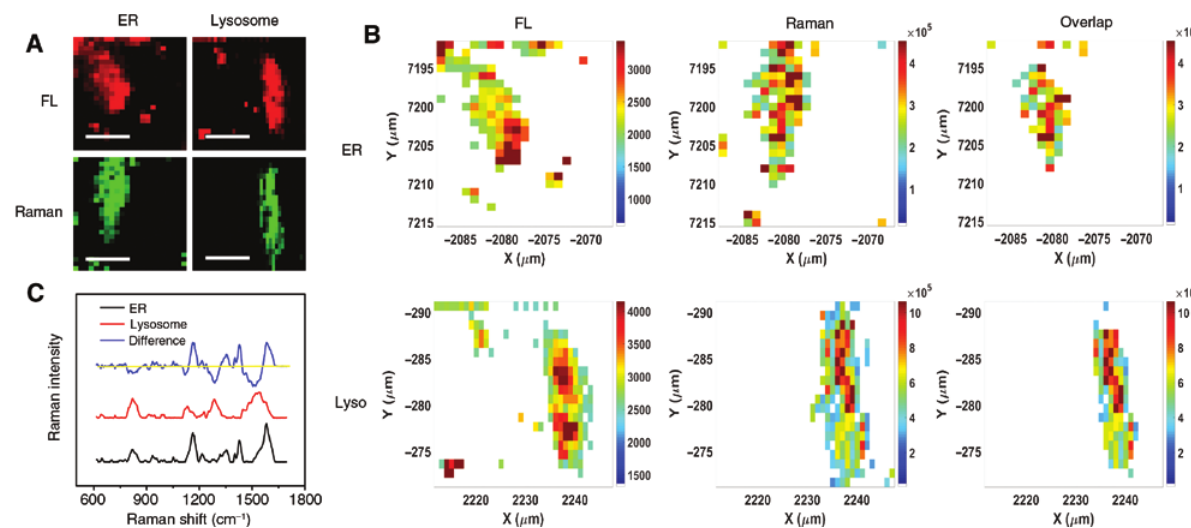
Figure 6: (A) SERS-fluorescence dual-mode imaging analysis of the subcellular localization of BP-Au NSs. Scale bar: 20 μ m. (B) Overlap analysis of the FL and SERS images. (C) SERS spectra extracted from the ER and lysosome of HepG2